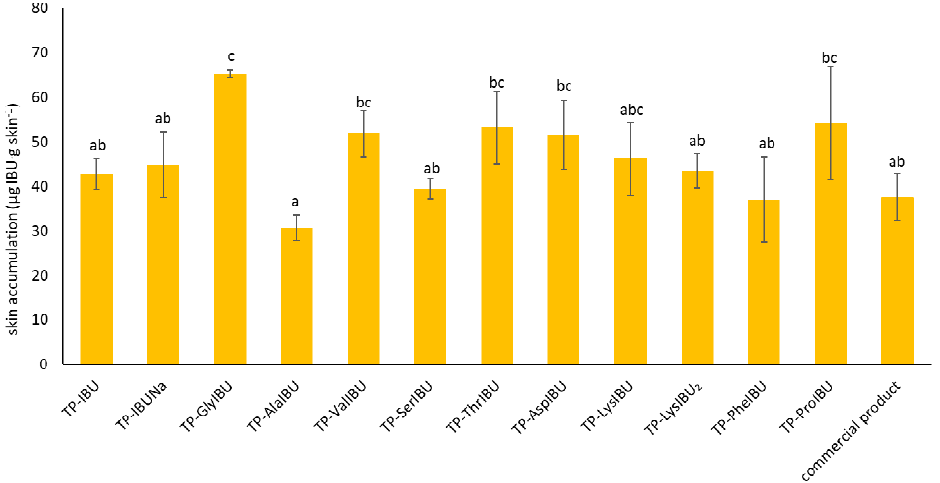
Figure 8. Significant differences in the cumulative mass between all analyzed compounds, taking into account all time points during the entire 24 h permeation, as estimated by Tuckey’s test, different letters—important differences between obtained transdermal patches and commercial product.